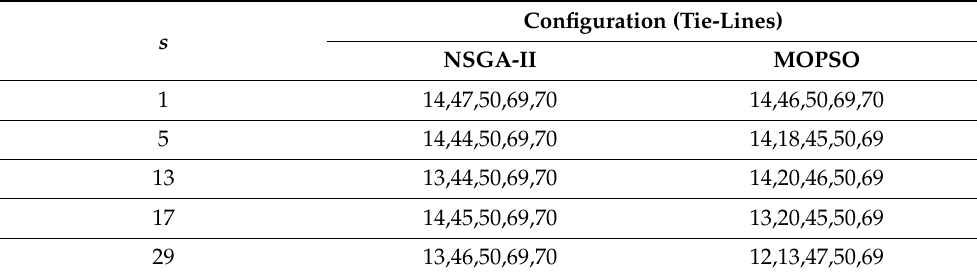
Table 10. The 69-node distribution network configurations at multiple scenarios.